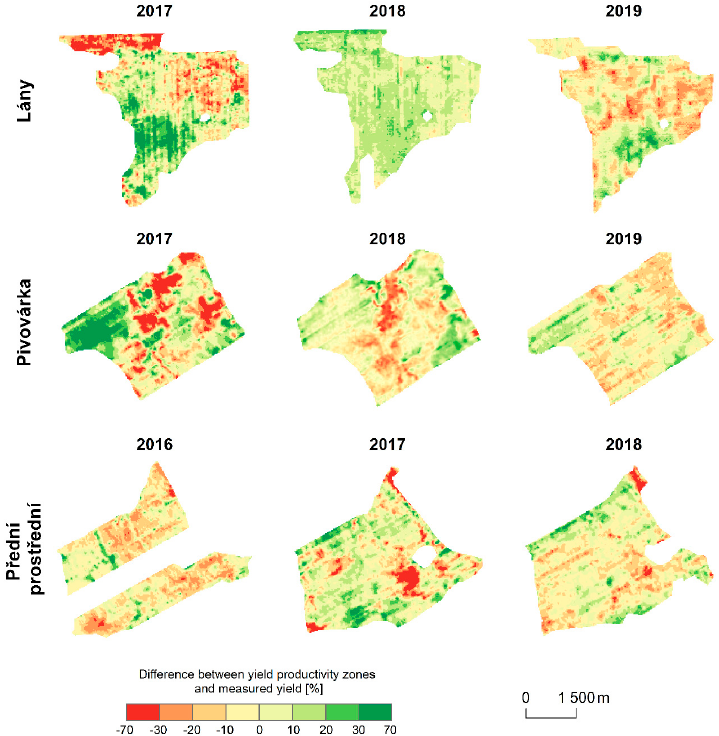
Figure 4. Di ff erences between the yield productivity zone values and yield measurements: subtraction of the yield productivity zones (prediction) from yield measurements (reference